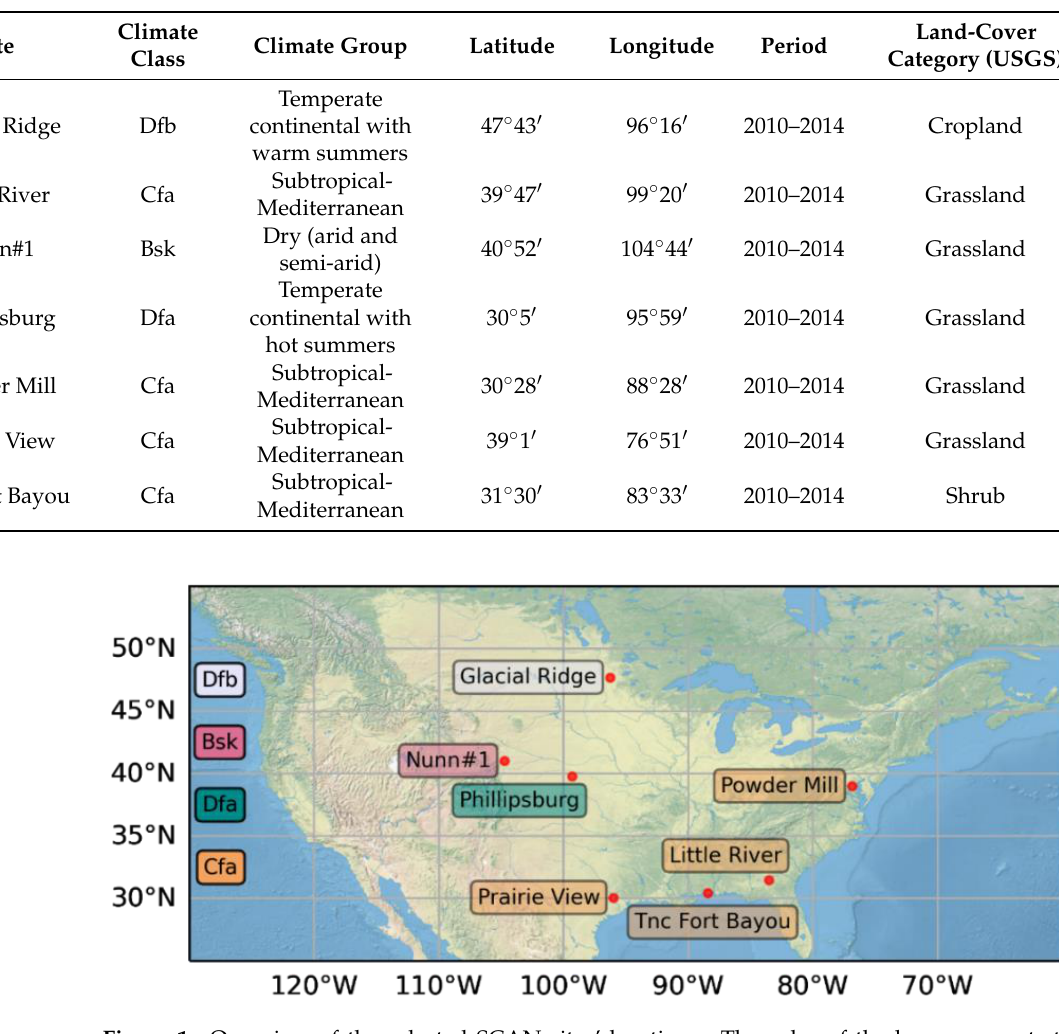
Figure 1. Overview of the selected SCAN sites’ locations. The color of the box represents the climate class.